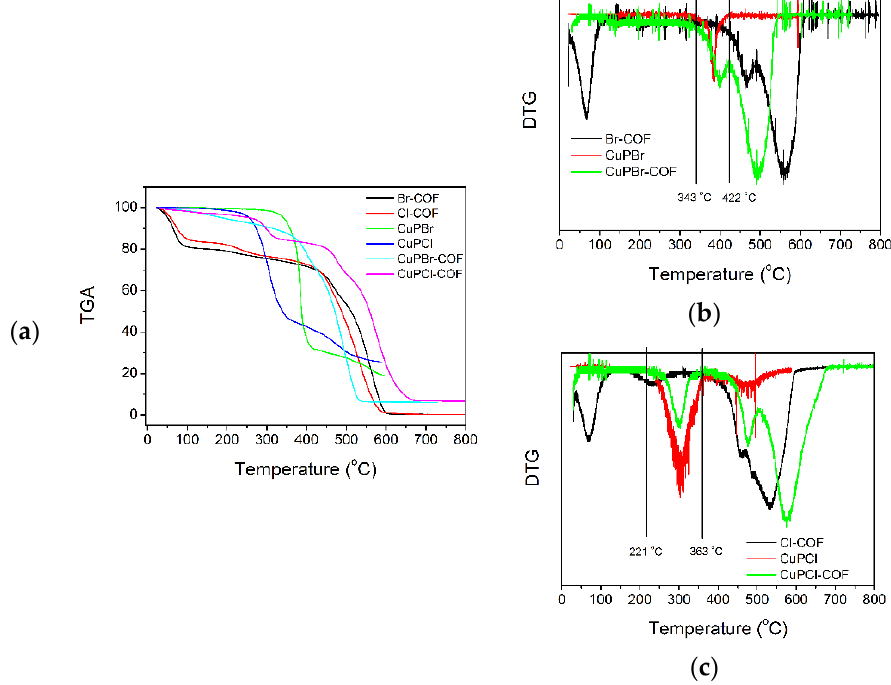
Figure 8. TGA ( a ) and DTG ( b , c ) curves of of CuPX, CuPX-COF and X-COF, X = Br, Cl.